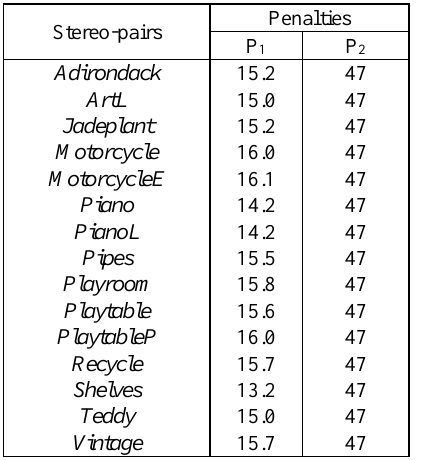
Table 1. Penalties estimated by the SGM-SAP method for each stereo-pair of the Middlebury 2014 dataset.